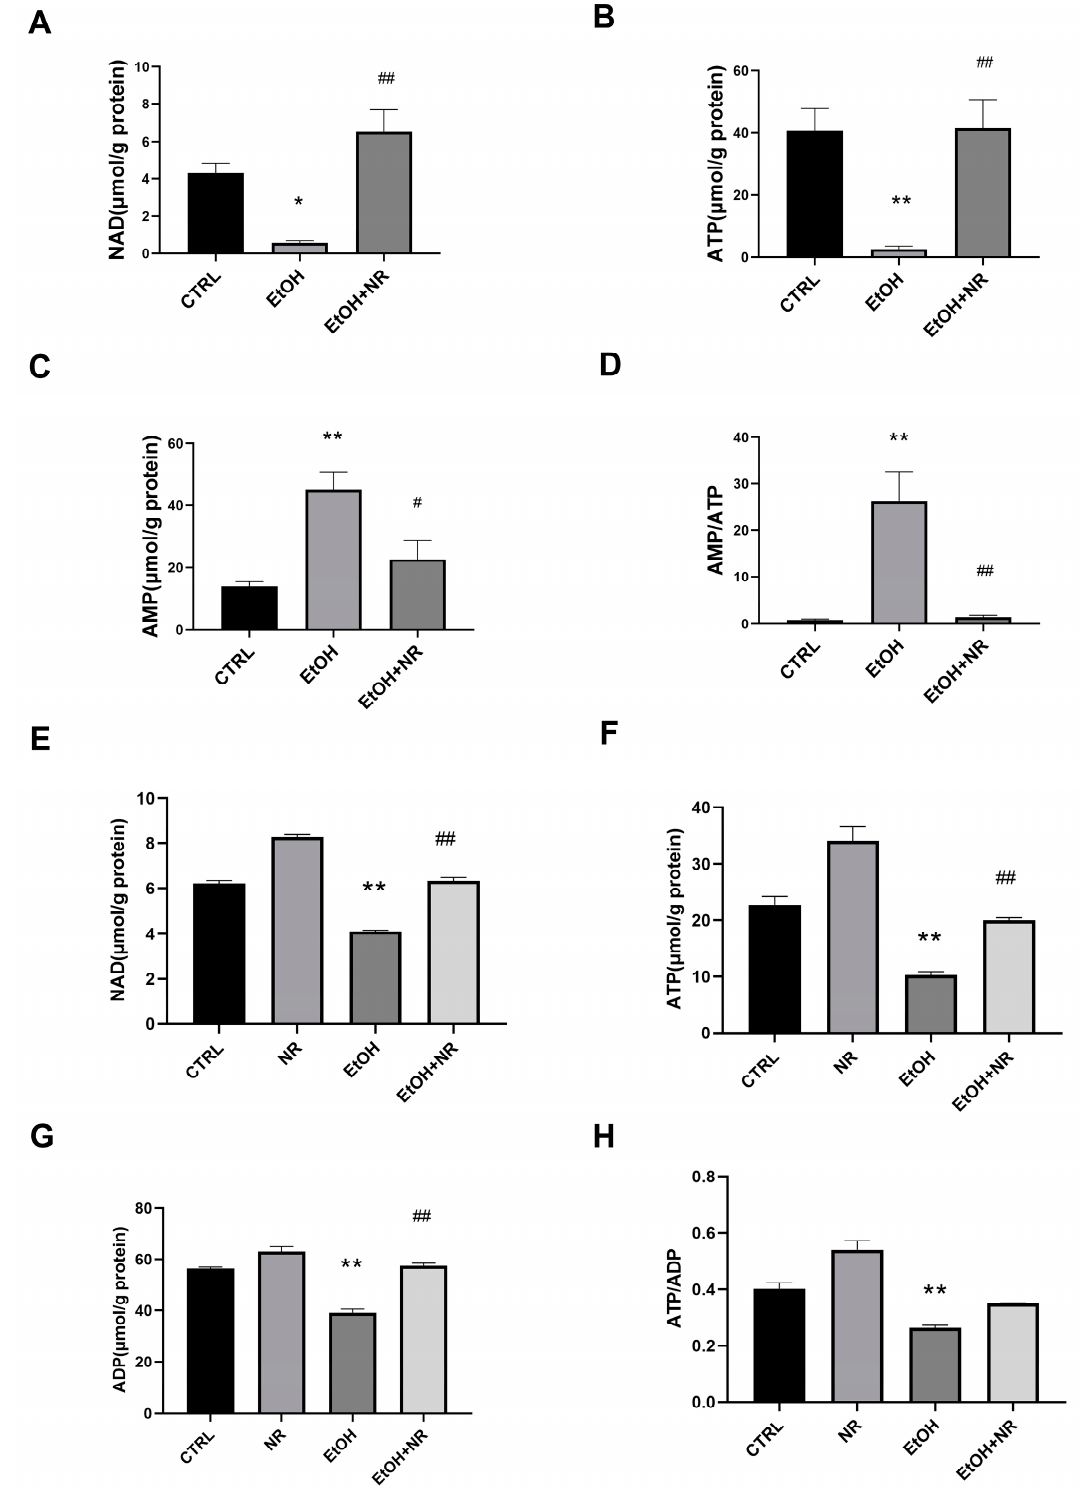
Figure 2. NR prevents ethanol-induced NAD and energy imbalance both in in vivo and in vitro experiments. ( A ) The LC/MS metabolomic analysis of NAD levels of terminal ileum. ( B ) The LC/MS metabolomic analysis of ATP levels of terminal ileum. ( C ) The LC/MS metabolomic analysis of AMP levels of terminal ileum. ( D ) The LC/MS metabolomic analysis of AMP/ATP ratios of terminal ileum. Mice in EtOH group and EtOH + NR group were fed a Lieber–DeCarli ethanol diet for 10 d followed by gavage of a single dose of ethanol with or without NR treatment. Mice in the control group